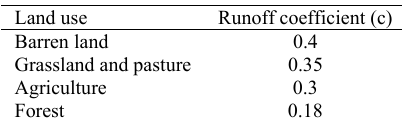
Table 1: Runoff coefficient (c) in the rational approach for natural watersheds